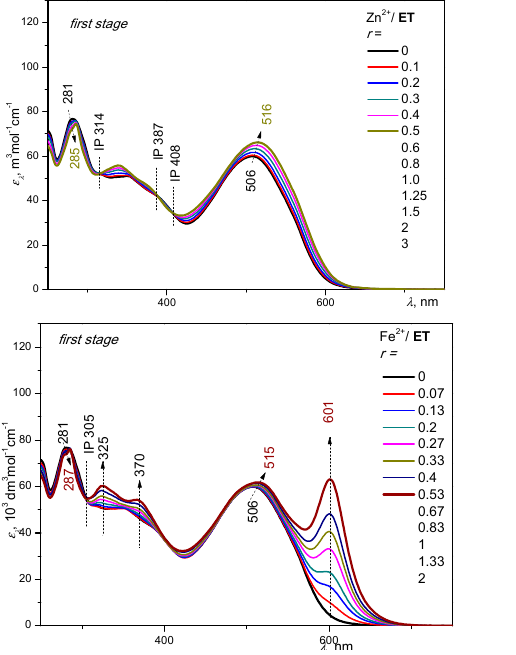
Figure 1. The UV/vis spectral changes accompanying assembly of Zn 2+ ( up ) and Fe 2+ ( down ) ions with unimer ET at mole ratios r from 0 to ca 0.5 ( left ) and at r > 0.5 ( right ).